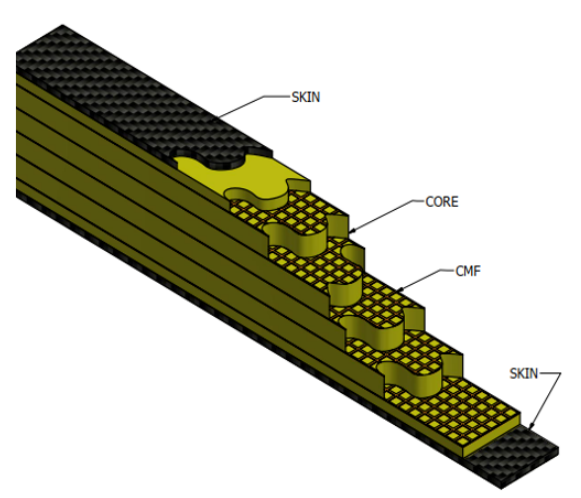
Fig. 3. CMF layout